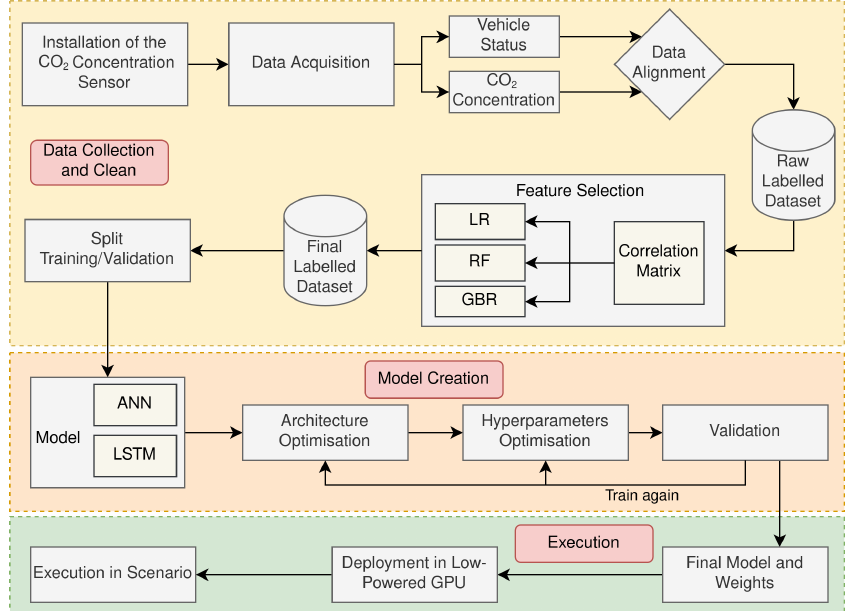
Figure 1. Workflow of the complete process from when the dataset was collected from the vehicle to the final execution, including designing and training of the ML